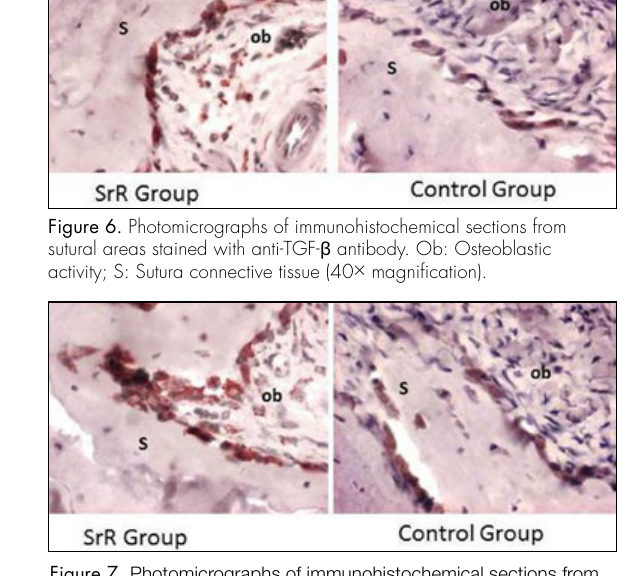
Figure 7. Photomicrographs of immunohistochemical sections from sutural areas stained with anti-VEGF antibody. Ob: Osteoblastic activity; S: Sutura connective tissue (40× magnification).